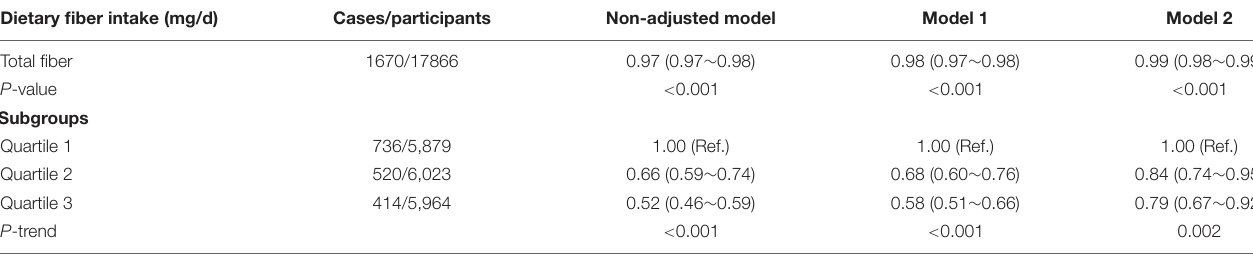
TABLE 3 | Weighted odds ratios (95% confidence intervals) of depression and different dietary fiber intake levels in different models.